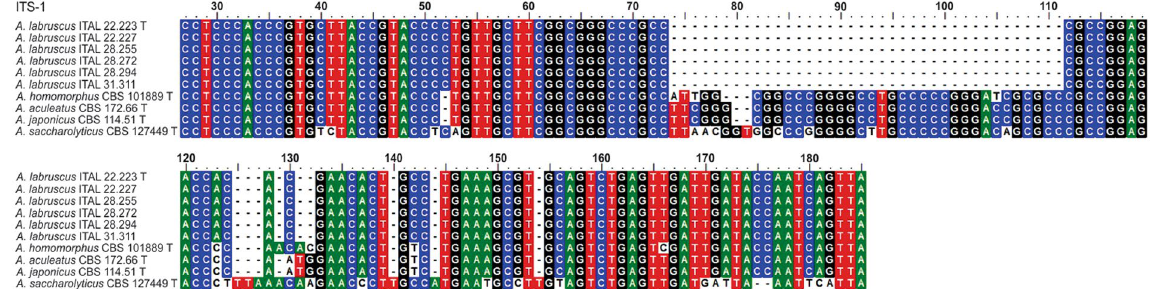
Figure 2. Sequence alignment of ITS1 from Aspergillus labruscus , A. aculeatus, A. homomorphus, A. japonicus and A. saccharolyticus .